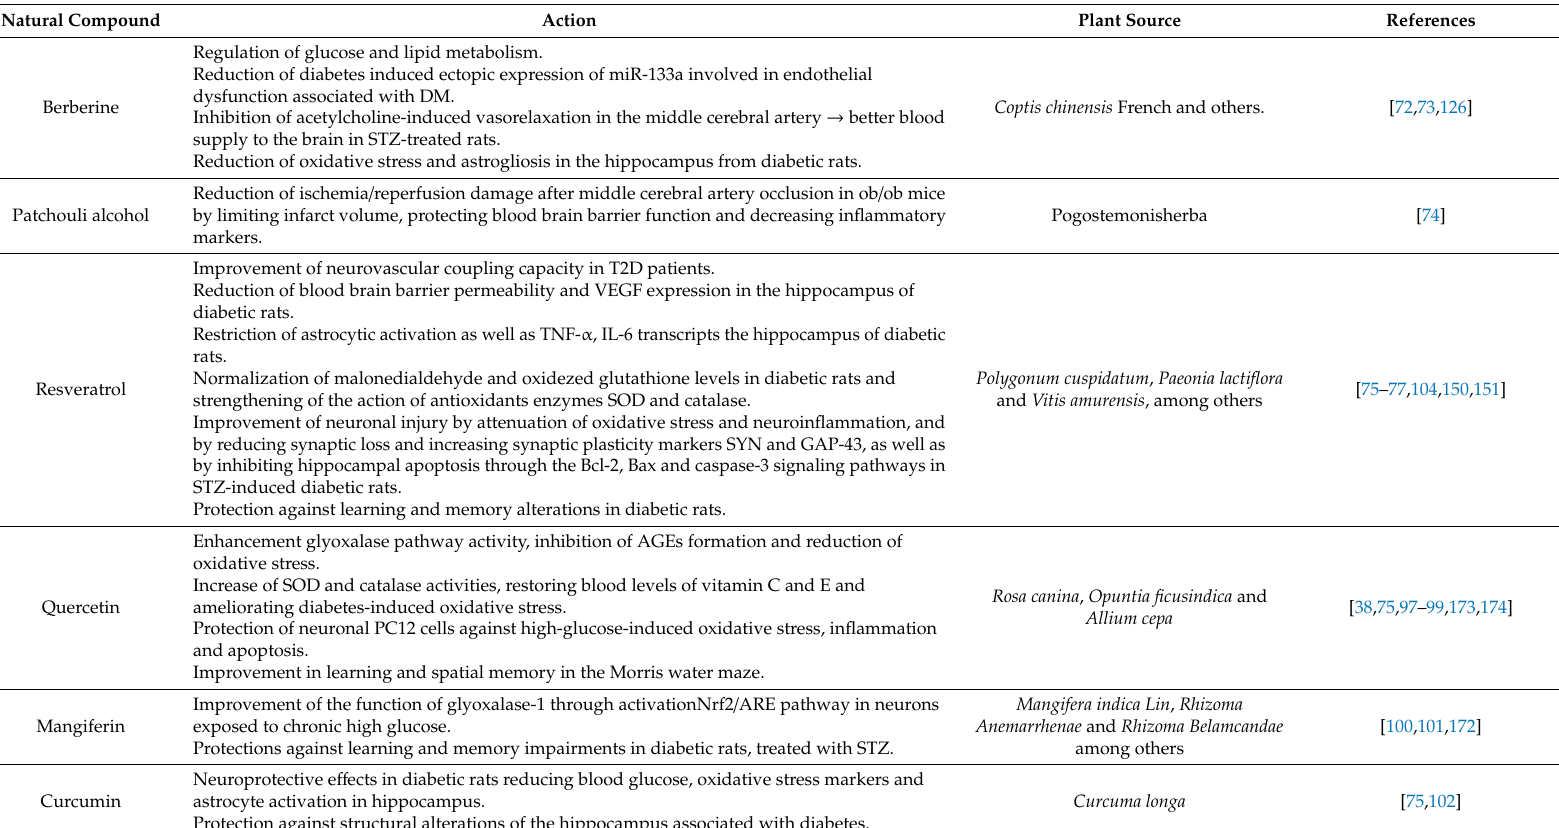
Table 1. Natural compounds and extracts with activity at central level associated with metabolic